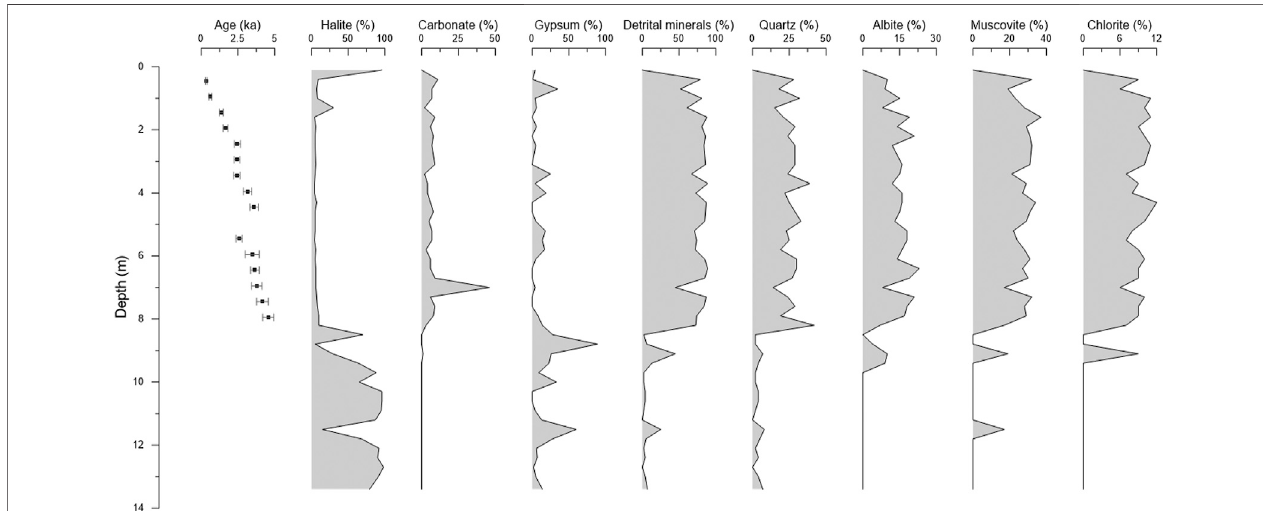
FIGURE 5 | Mineral composition and dating results in the Section DT in East Taijnar Salt Lake.